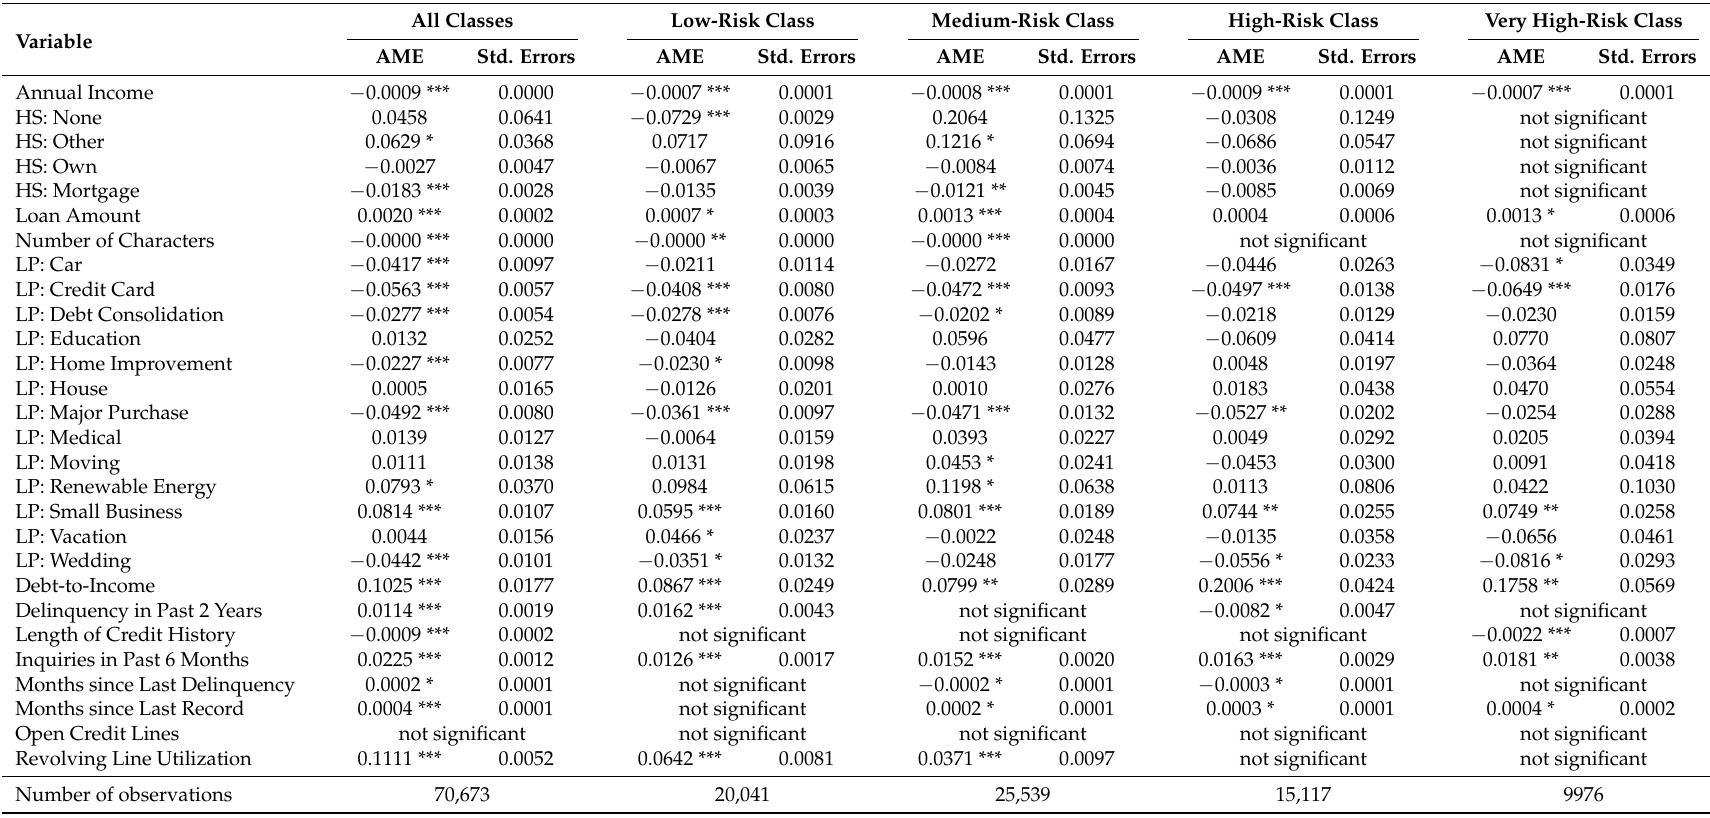
Table 4. Regression results for all classes and each class